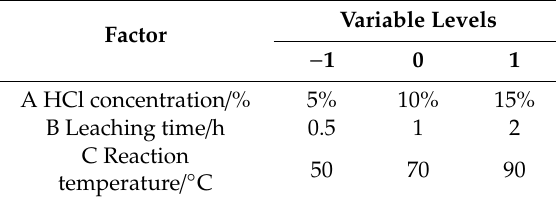
Table 1. Response surface test factor level